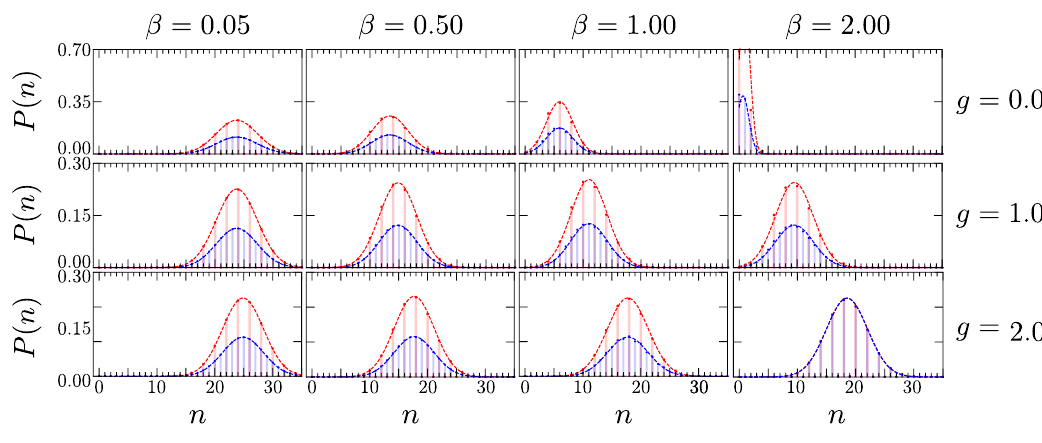
Figure 3: Kink-number distribution at thermodynamic equilibrium. Probability distribution of the number of kinks P ( n ) as a function of the magnetic field g and temperature T for a chain of L = 50 spins. The exact probability distribution Eq. (85) (red bars) is compared with the simplified expression in Eq. (89) (blue bars). Only in the low-temperature paramagnet the PPA is accurate. Further, the normal (Gaussian) approximation to the histograms is also shown (dashed